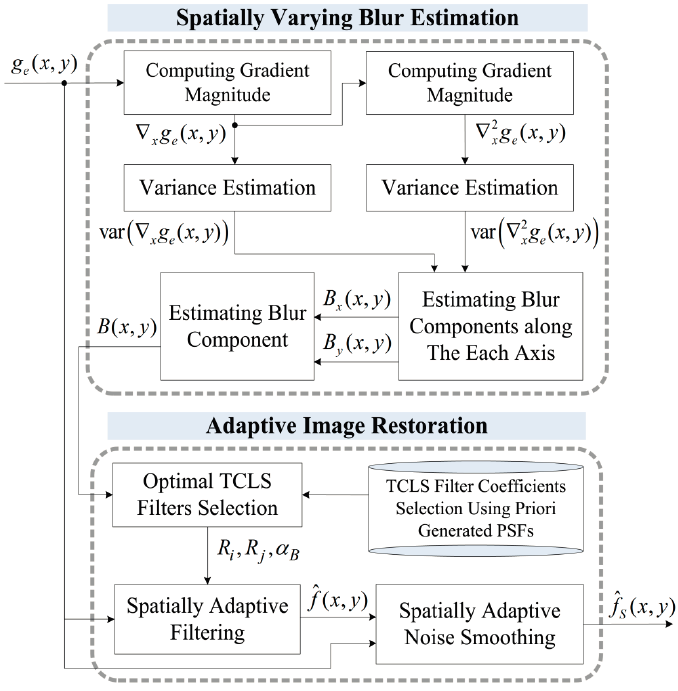
Figure 1. Block diagram of the proposed adaptive image restoration algorithm. (The derivative operations are shown in only the horizontal direction for simplicity but the real system computes both horizontal and vertical